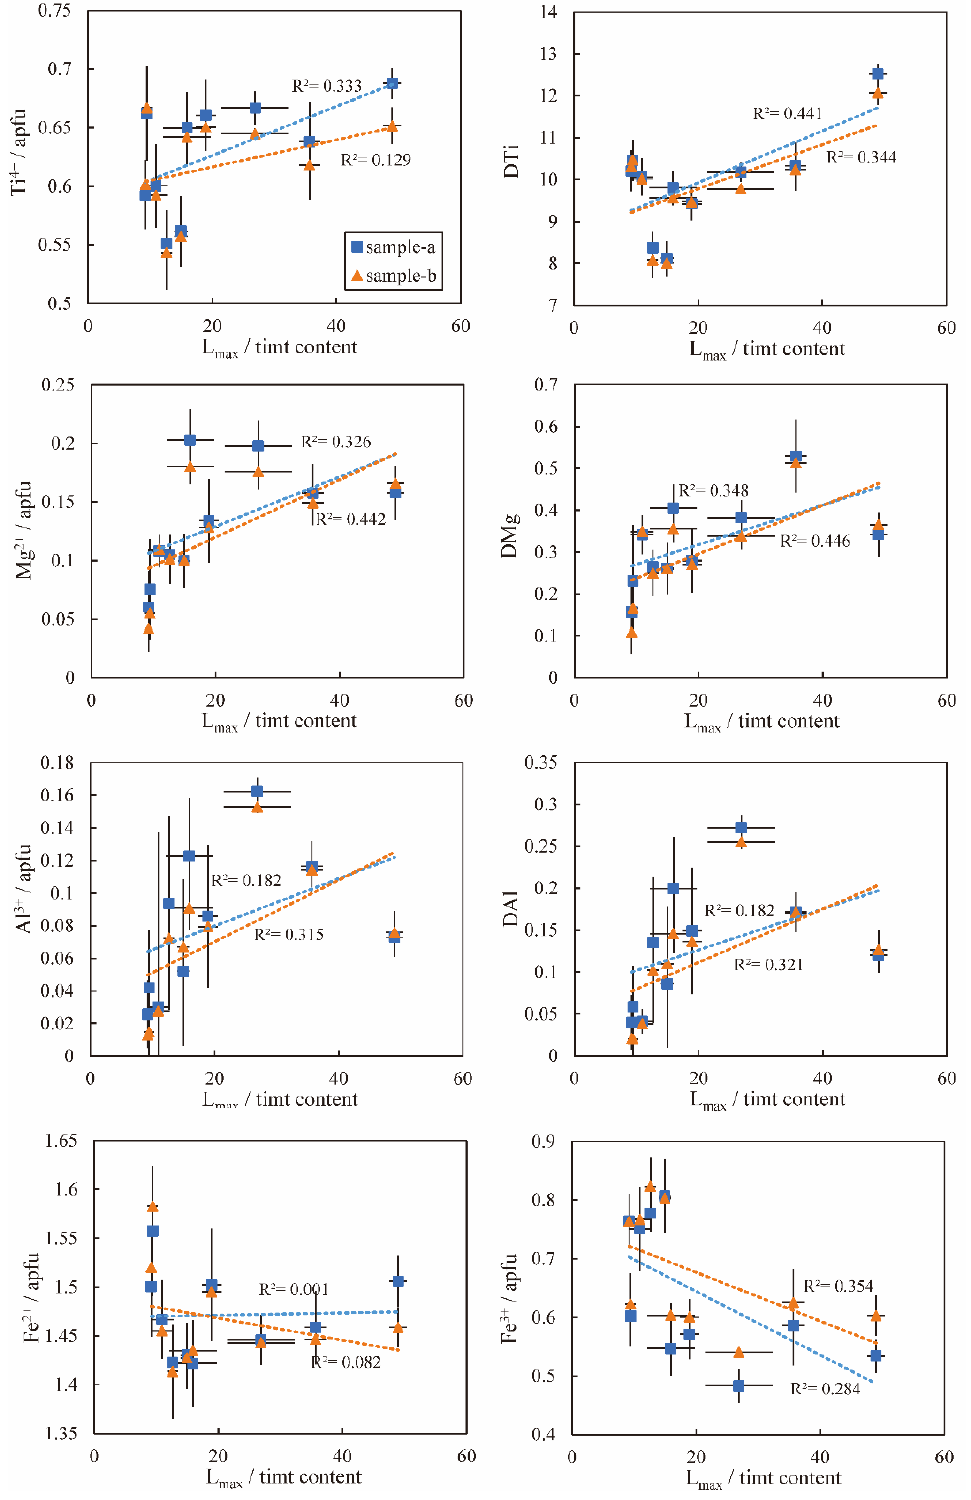
Figure 11. Relationship between titanomagnetite major element contents (reported by atom per formula unit (apfu)) and Mg, Al, Ti partition coefficient (DMg, DAl and DTi: MgO, Al 2 O 3 and TiO 2 content in titanomagnetite and rock are reported by weight percent (wt%)) in Hannuoba samples and L max /timt content. Two independent tests were conducted to obtain two sets of data (15 particles for each test), marked as ‘sample-a’ and ‘sample-b’, respectively. Some error bars smaller than the symbols are not shown.